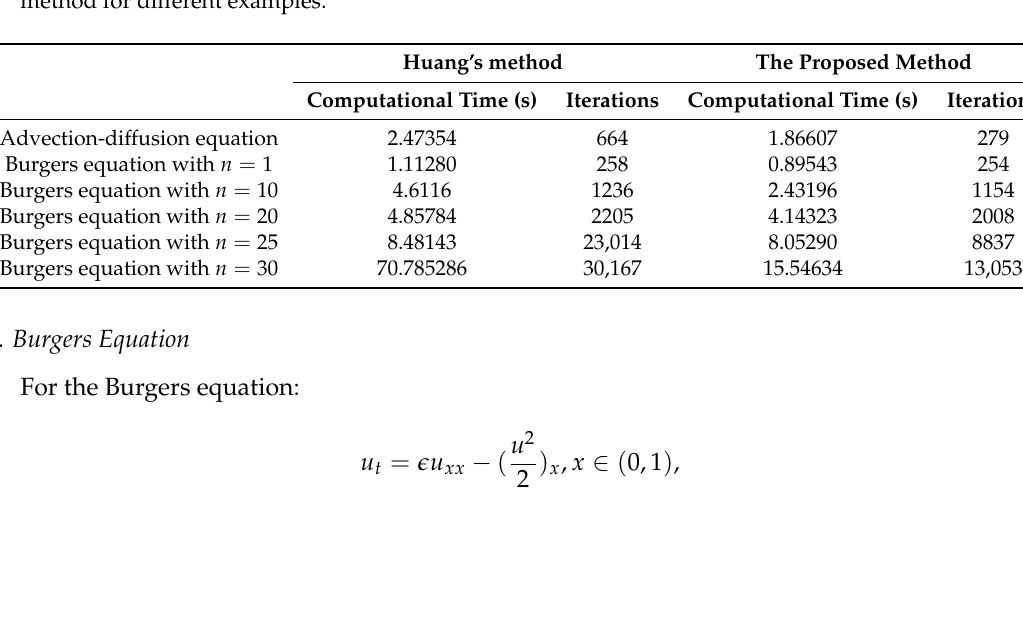
Table 1. The comparison of computational time and iterations of Huang’s method and the proposed method for different